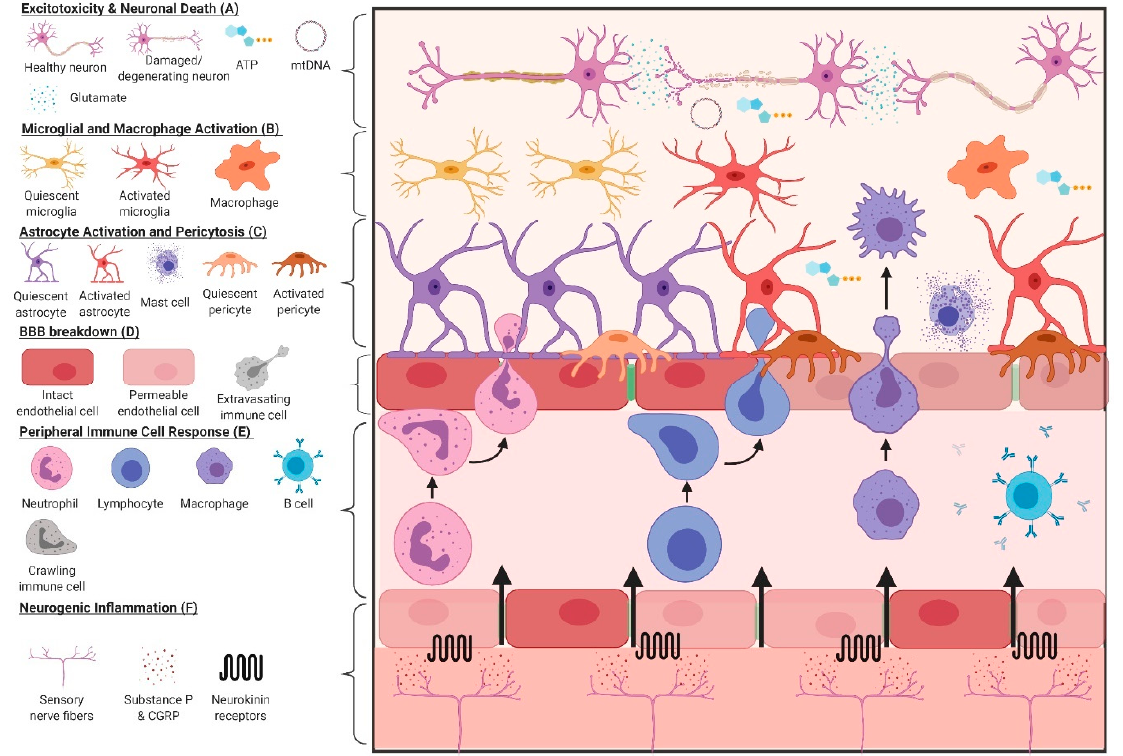
Figure 1. Key mechanisms of inflammation following TBI. ( A ) Following a TBI, an increased influx of Ca 2+ and Na + into neurons facilitates excessive glutamate release into the synaptic cleft and consumption of ATP stores by Na/K ATPases to restore membrane potential. Increased intracellular Ca 2+ can overwhelm the buffering capacity of the mitochondria and cause membrane depolarization, leading to organelle fragmentation and the impairment of oxidative phosphorylation. If the disruption is severe, cellular death can occur and the leakage of DAMPs into the extracellular space can elicit an immune response. ( B ) Detection of products from neuronal damage, including to myelinated tracts, can activate surrounding microglia via pattern recognition, purinergic, and glutamate receptors. Cells use these chemotactic signals to migrate towards the site of injury and launch an inflammatory response, including the secretion of cytokines and gliotransmitters to alert astrocytes. ( C ) Closer to the blood–brain barrier (BBB), activated astrocytes and pericytes react to damage and extracellular DAMPs by reducing the coherence of the BBB through the retraction of endfeet and migration away from the vasculature. Mast cells on the abluminal side of the BBB can degranulate in response to TBI, releasing extracellular matrix (ECM)-degrading enzymes, neurotransmitters and histamine. ( D ) Increased expression of adhesion molecules on endothelial cells following TBI, such as ICAM-1 and VCAM-1, increase the attachment and extravasation of peripheral immune cells into the brain. ( E ) BBB breakdown and leakage of DAMPs into the peripheral circulation act as chemoattractants for leukocytes. Following TBI, neutrophils, T-cells, and monocytes have been documented to penetrate the BBB and perpetuate the immune response. B-cells can produce autoantibodies to cerebral antigens, such as myelin basic protein (MBP) and glial fibrillary acidic protein (GFAP), propagating inflammation. ( F ) Mechanical stimulation of transient receptor potential (TRP) channels on sensory nerve fibers can release substance P (SP) and calcitonin gene-related peptide (CGRP), increasing the permeability of the endothelium to immune cells and DAMPs, and facilitating vasogenic edema. Created with Biorender.com.